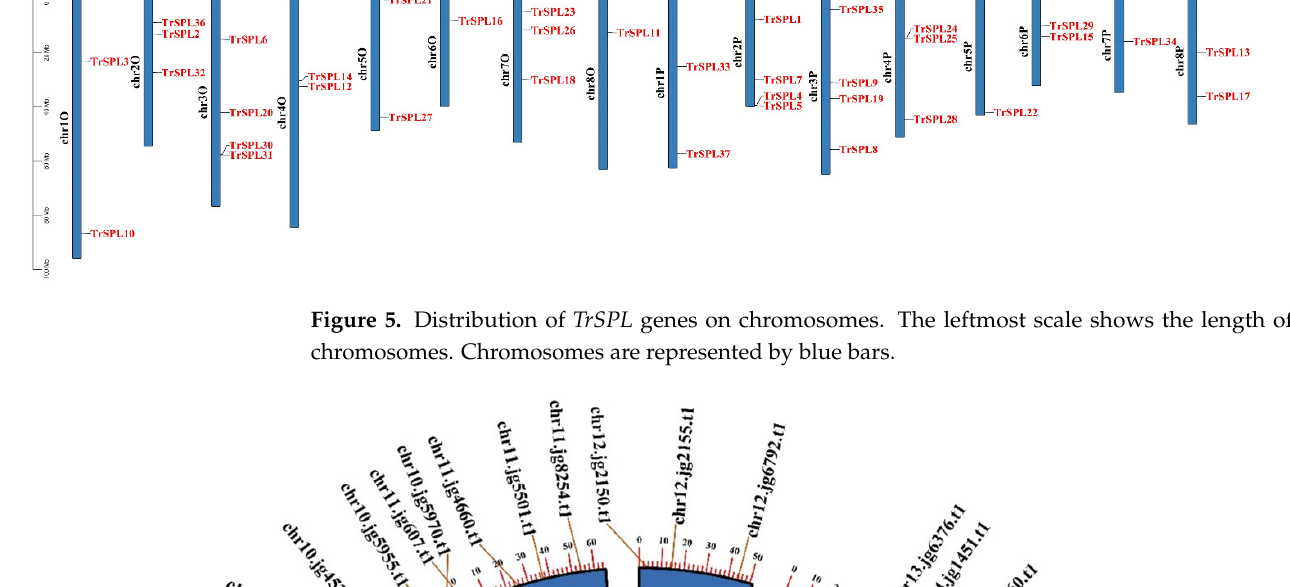
10 of 18 Figure 4. Analysis of conserved motifs and gene structure under the phylogenetic tree of T. repens SPL gene family. ( a ) A phylogenetic tree was constructed using the full-length protein sequence of T. repens SPL gene family. Different evolutionary clades were marked with different colors. ( b ) Con- served motifs predicted in TrSPL proteins. The 10 motifs are represented by squares of different colors. ( c ) Exons and introns are represented by colored squares and black lines. The SBP conserved domain and Ankyrin repeat region were clearly marked and 0, 1, and 2 indicate intron phase.